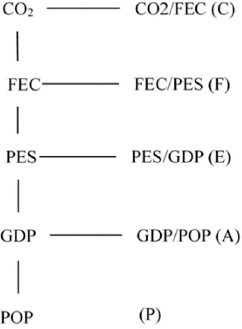
Figure 1. Chain decomposition methodology.